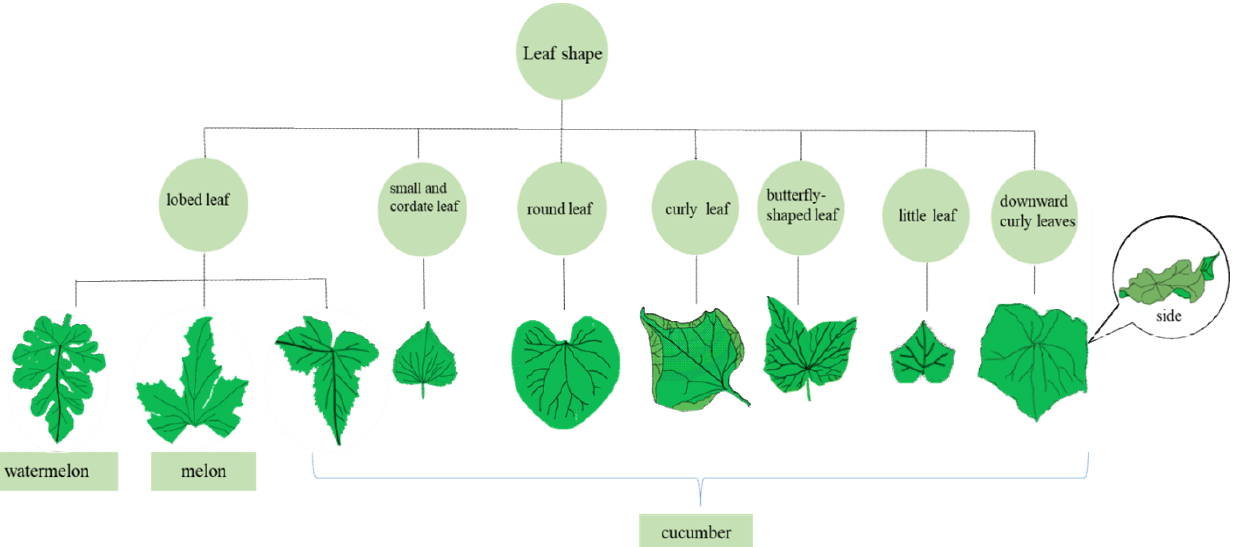
Figure 1. Leaves of several leaf-shaped mutants of Cucurbitaceae. Table 1. Genes involved in leaf shape regulation of cucurbitaceae.